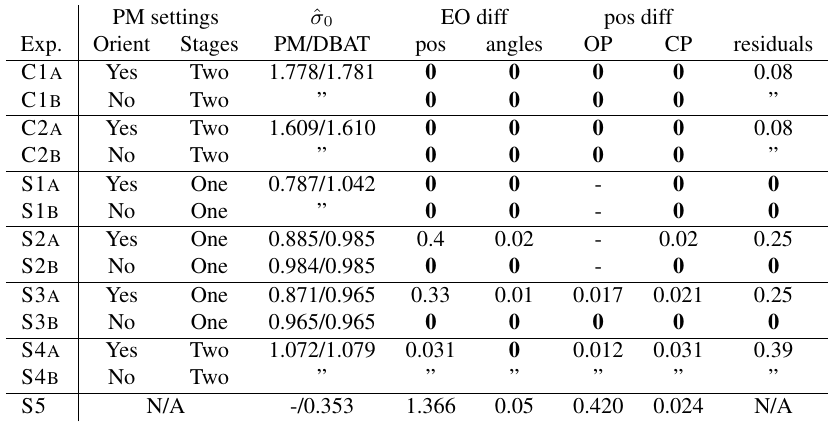
Table 3. Results for the experiments. The (cid:99) σ 0 estimated by PM and DBAT are given together with the maximum absolute difference between the DBAT and PM/PS estimates of the EO, OP, and CP parameters, and the image residuals. The position, angle, and residual units are meters, degrees, and pixels, respectively. All differences below 5 × 10 − 4 in their respective units are marked as zero and were furthermore below 0.1 times their respective posterior standard deviation σ post . The non-zero values except for experiment S5 were all below 0 . 5 σ post . The S5 EO differences were around 6.5 σ post , the OP/CP differences 1 . 7 σ post – 2 . 3 σ post .